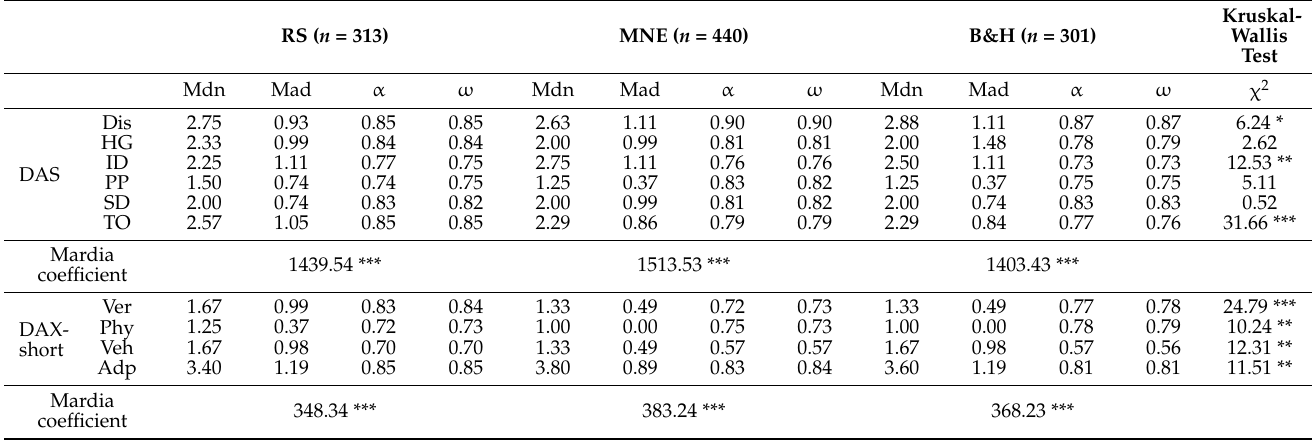
Table 2. Descriptive statistics, internal reliability analysis, Kruskal–Wallis tests and multivariate normality test statistics for study variables across countries.